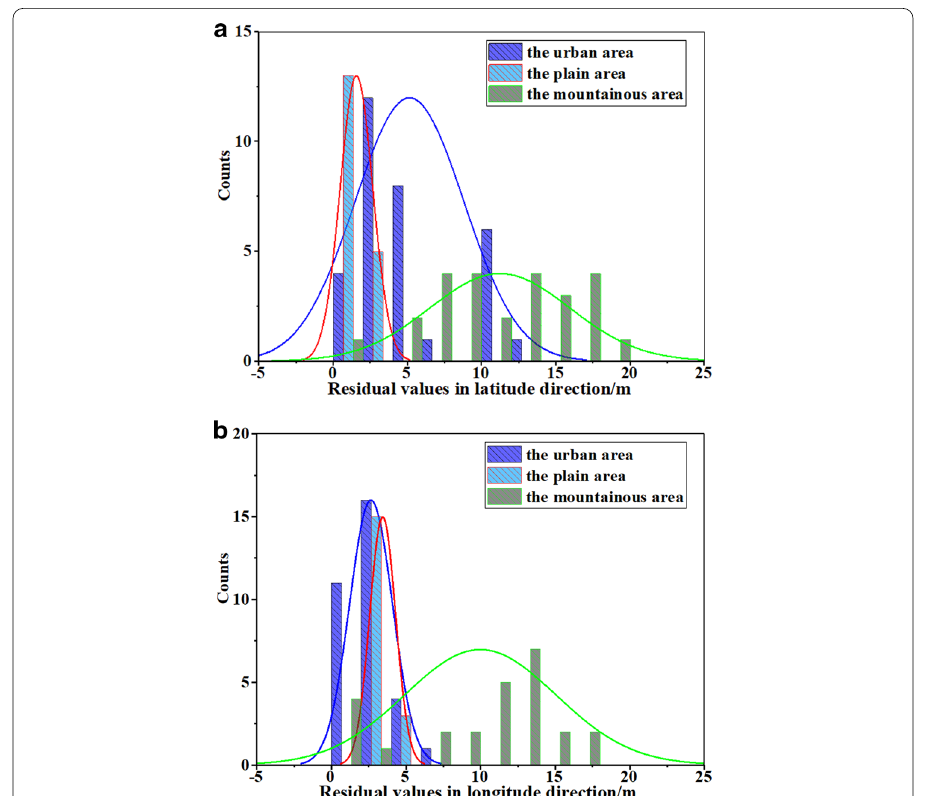
Fig. 3 Residuals of the Hongqi-1-H9 imagery under three different terrains in latitude and longitude.x and y axes correspond to the residual values of three different areas and the corresponding residual counts, respectively